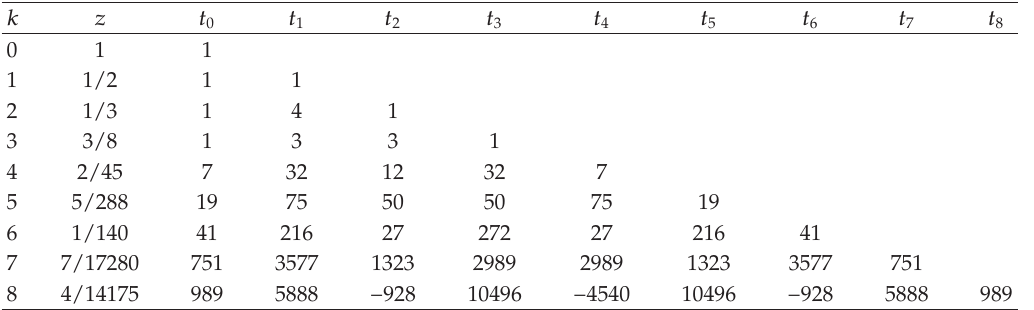
Table 1: Closed Newton-Cotes integral